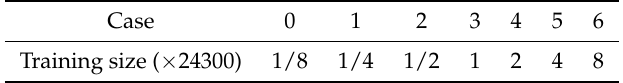
Table 3. The different sizes of training data set when training the ANN.